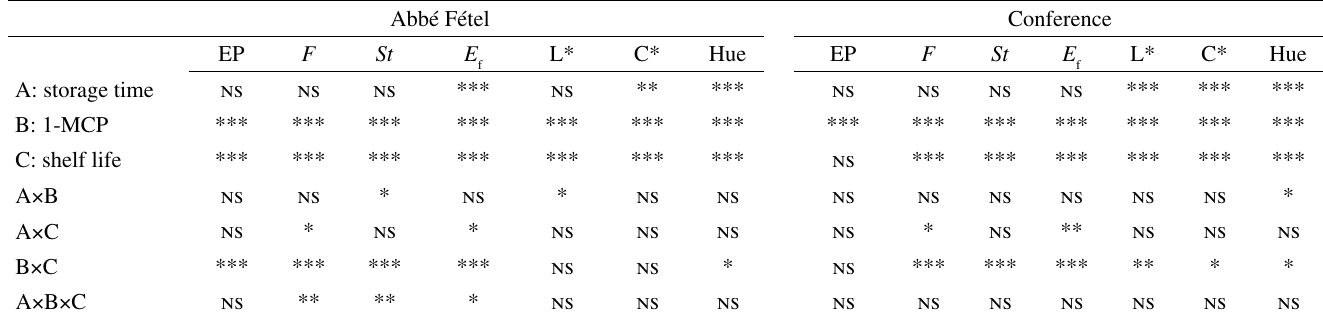
Table 3 - Multifactor ANOVA results for pulp mechanical characteristics (firmness, F , stiffness, St and energy-to-rupture, E (lightness, L*; chroma, C* and hue) and ethylene production rate (EP) for ‘Abbé Fétel’ and ‘Conference’ pears Abbé Fétel